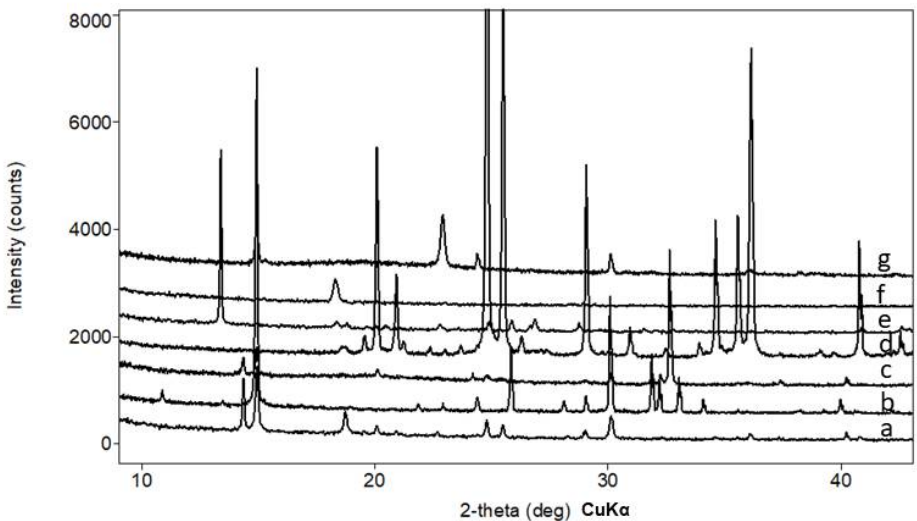
Figure 3. Selected X-ray diffraction pattern of the oxalates crystals (underlying stone